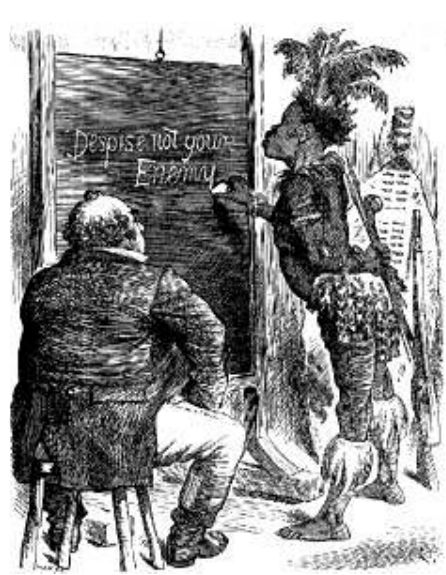
Figure 2. Sir John Tenniel, A Lesson (1879)